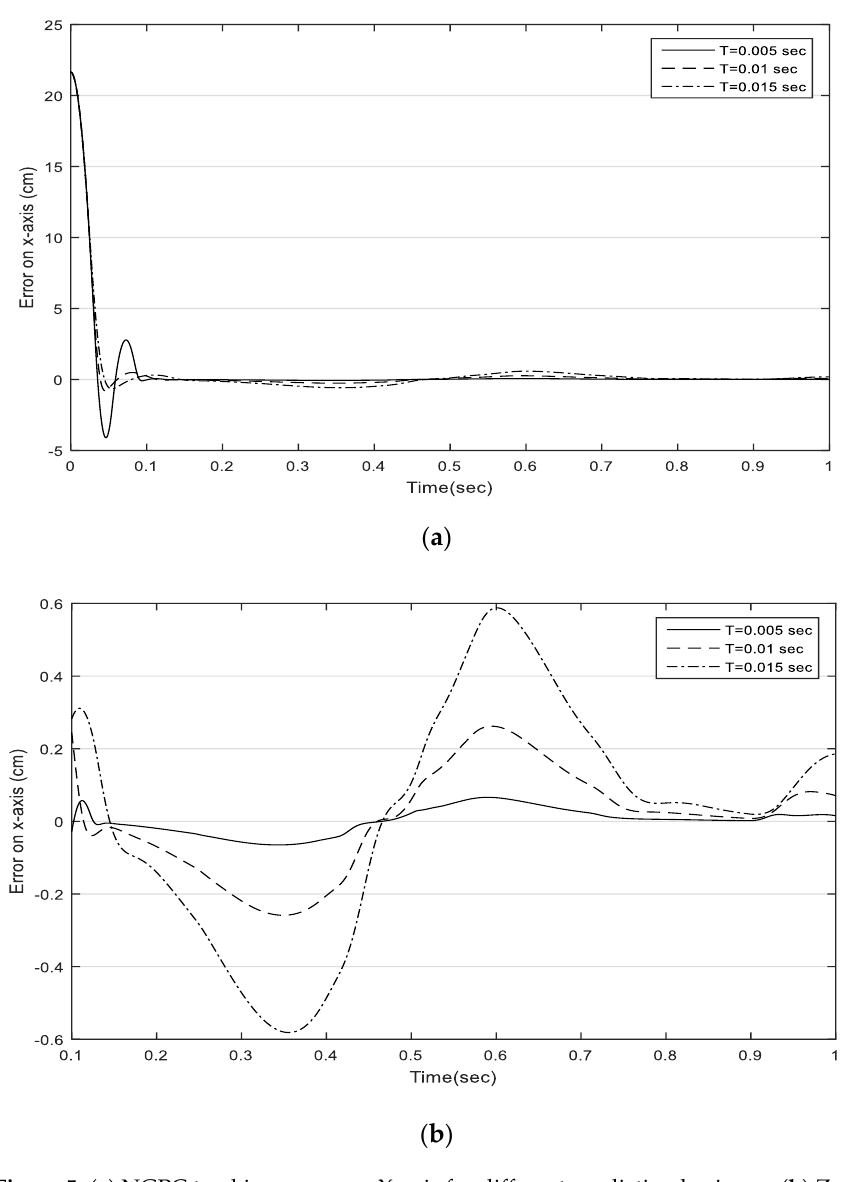
Figure 5. ( a ) NGPC tracking errors on X-axis for different prediction horizons. ( b ) Zoom on X-axis tracking errors.